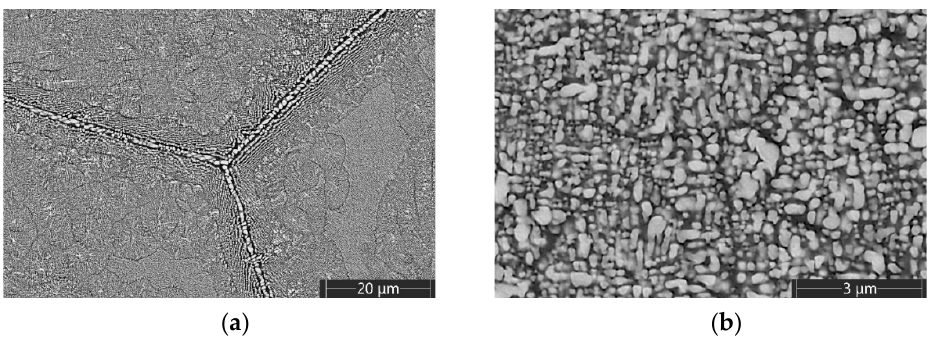
Figure 5. BSE images of TaTiZr: ( a ) a low-magnification image showing a coarse grain structure of the matrix phase, finer domain structure inside grains, and second phase precipitates at grain boundaries and inside grains; ( b ) a higher-magnification image showing domain boundaries (they have a dark color) and nanometer-size precipitates inside the domains. Table 5. Composition (in at.%) of the matrix phase and second-phase particles in TaTiZr. Element